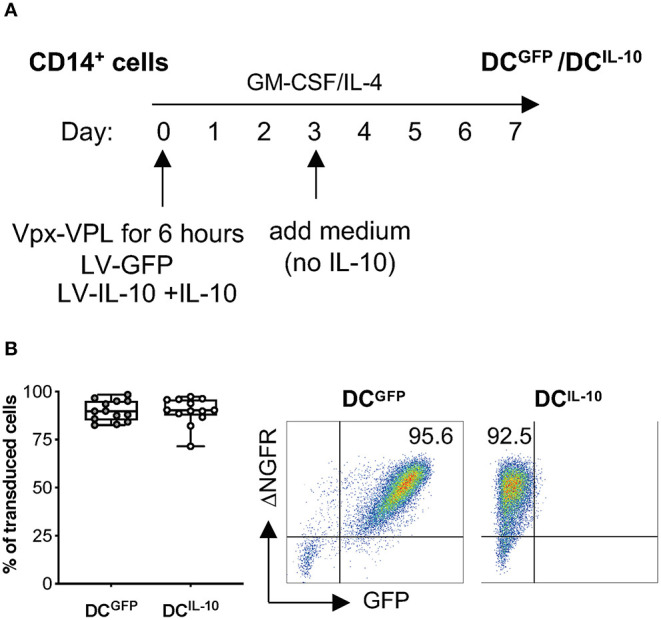
BdLV-mediated gene transfer to engineer human monocyte-derived DC. CD14+ cells isolated from peripheral blood of healthy subjects were treated with Vpx-VLP for 6 h and then transduced with LV-IL-10 (DCIL−10) in the presence of exogenous IL-10 at day 0 during DC differentiation. As control, DC transduced with LV-GFP (DCGFP) were differentiated from the same donors. (A) Protocol for bdLV-mediated transduction of monocyte-derived DC is depicted. (B) Transduction efficiency was quantified based on ΔNGFR expression on differentiated DC. Each dot represents a single donor (n = 13), lines indicate median, while whiskers are minimum and maximum level (left panel). Dot plots from one representative donor are presented. Numbers represent percentage of positive cells (right panel).